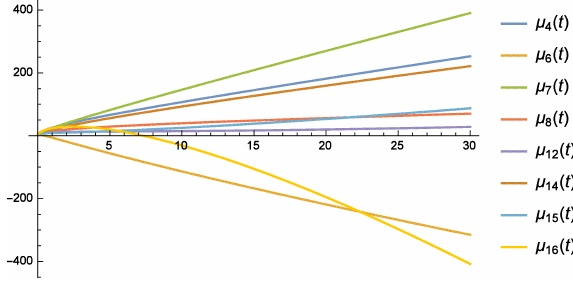
Fig. 9. The behaviour of the stocks in Figure 8b for t 2 Œ0;30(cid:141) . The state of TELAVIV would be balanced with DOW, and FTSE with CAC for the long time